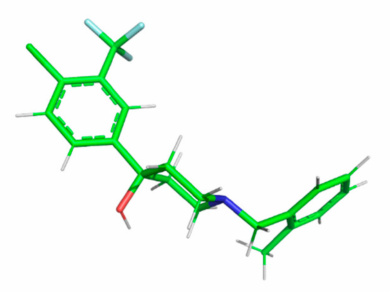
Figure 1. Representative example (PIPD1) of a piperidinol-containing molecule evaluated by de Ruyck et al.